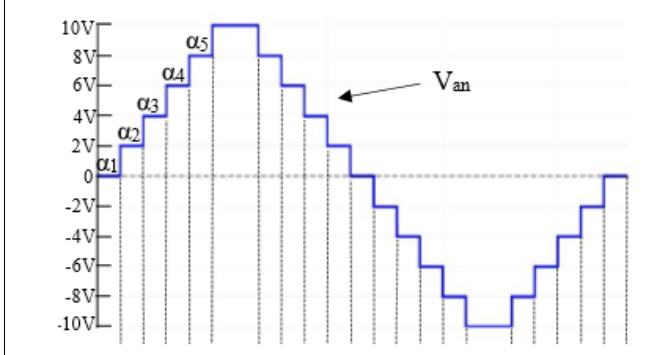
Figure 7: Generalized waveform for an inverter with 11 voltage levels.